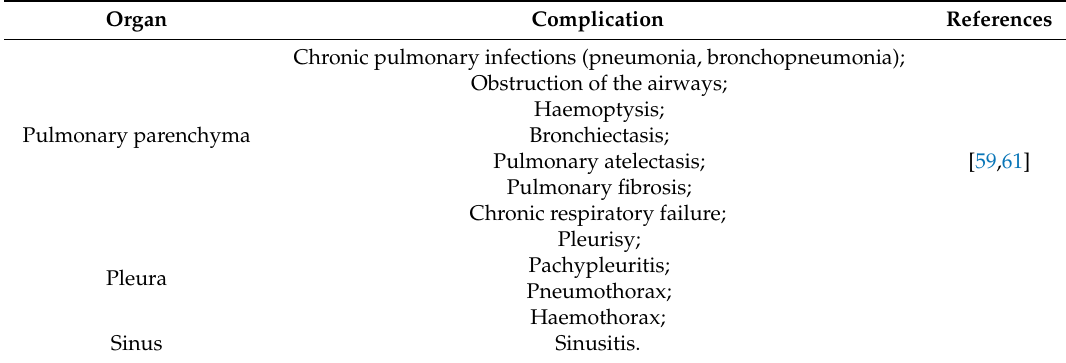
Table 5. Pulmonary manifestations in patients with